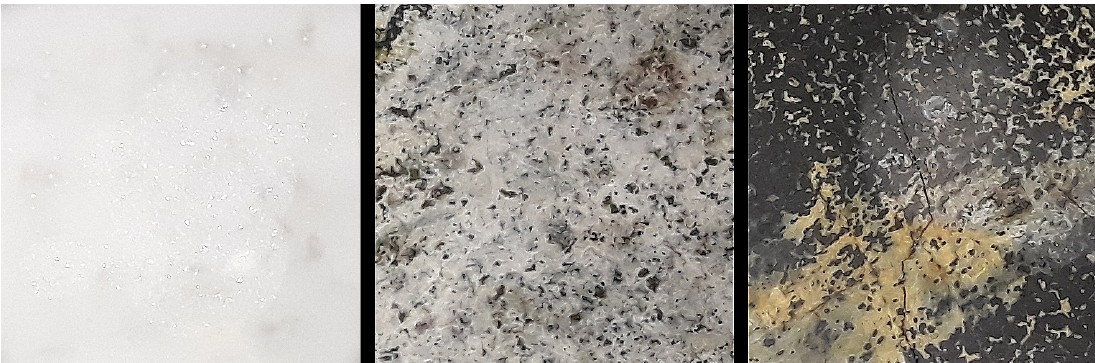
Figure 4. Photograph of the three tested rocks: marble ( left ), copper ore ( center ), and nickel ore ( right ). The dimensions of sample imaged are about 50 mm × 50 mm. Marble has a high degree of homogeneity, while ores show random inhomogeneities in size and distribution.